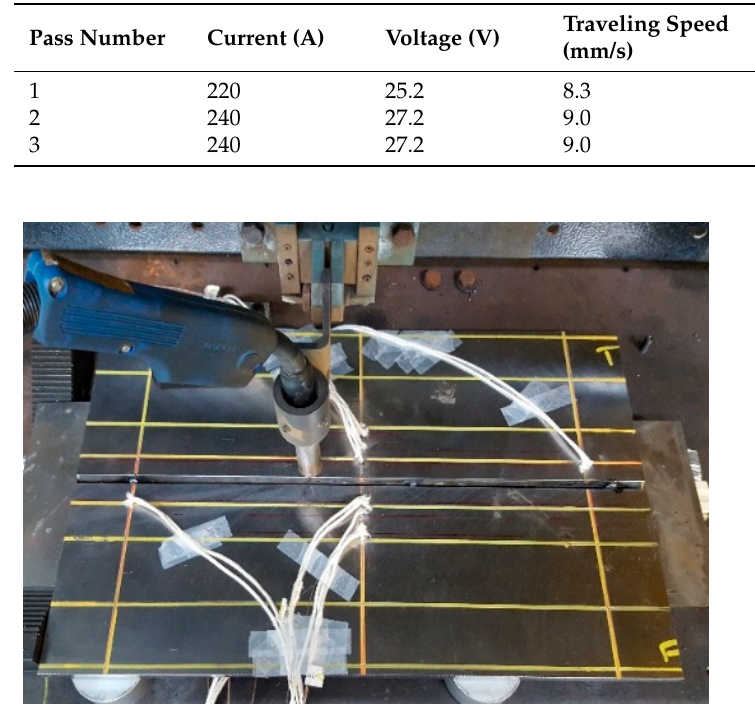
Table 1. Welding conditions for multi-pass butt-joint.